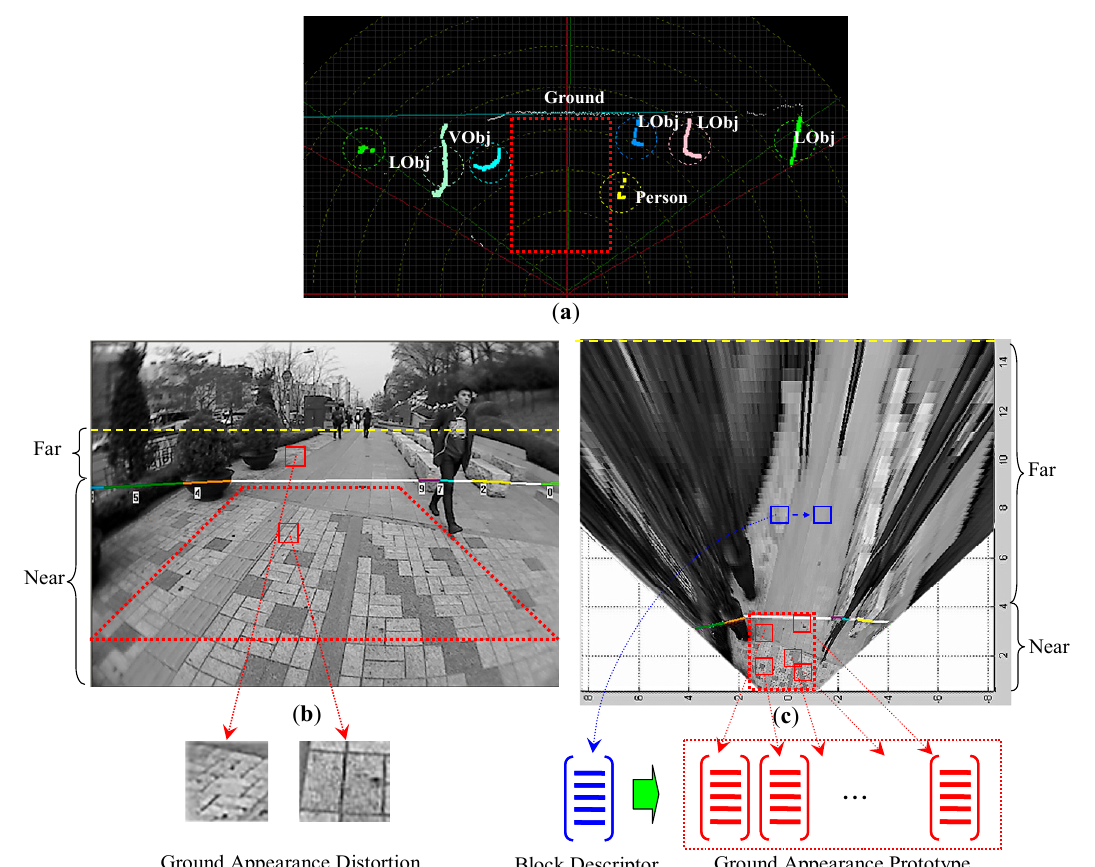
Figure 4. Cross-field appearance interpretation. ( a ) Block sampling ROI in the range data domain; ( b ) Block sampling ROI in the original image domain; ( c ) Appearance prototype building and matching on top-view image domain.